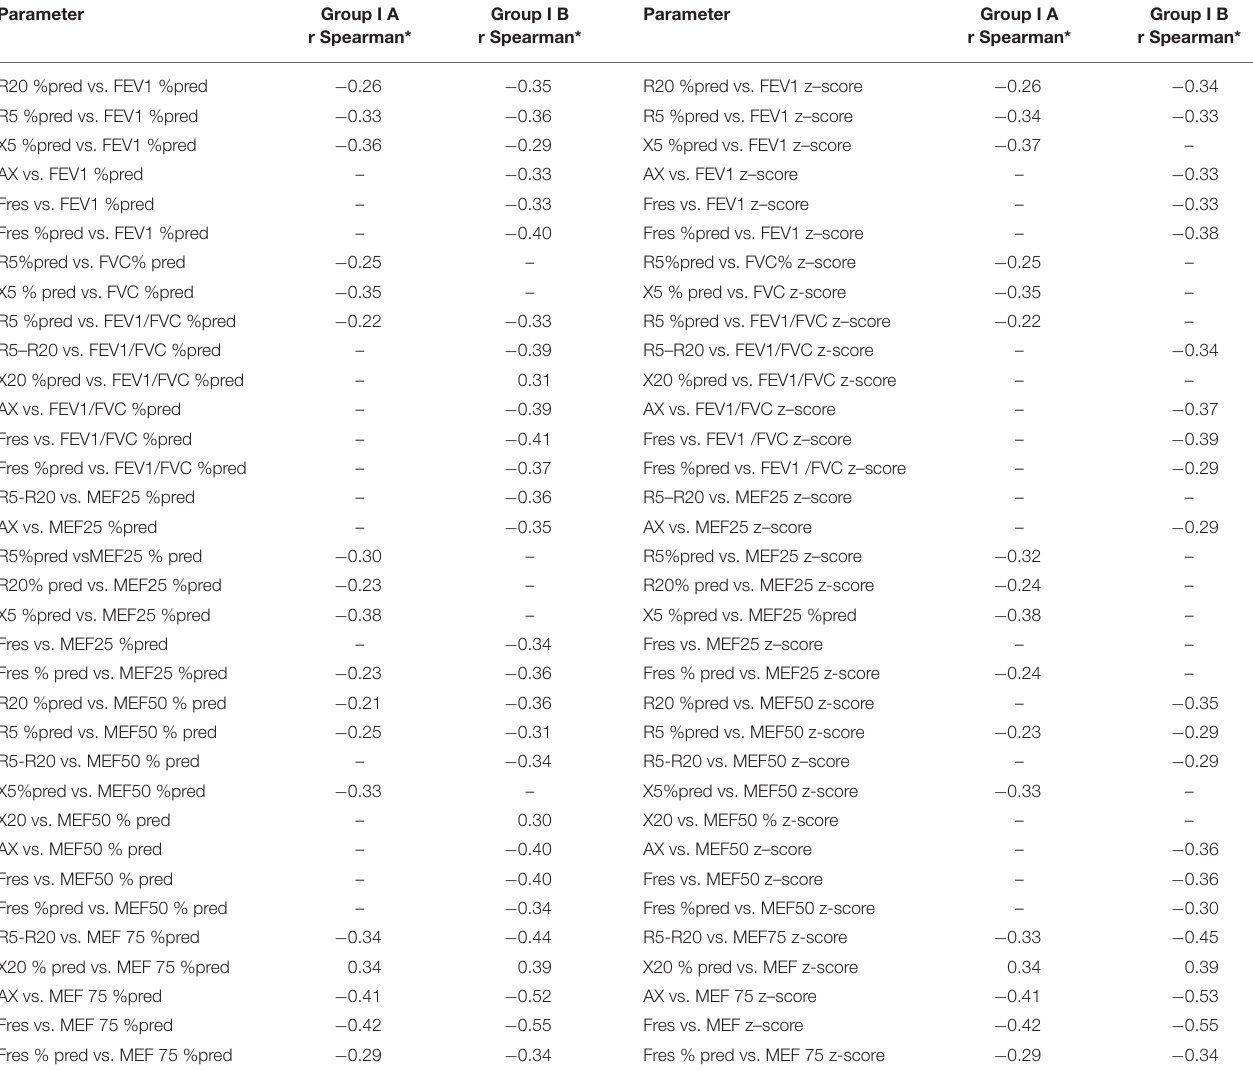
TABLE 2 | Correlations between IOS and spirometry parameters in subgroups: subgroup IA without spirometric features of obstruction and IB with obstruction